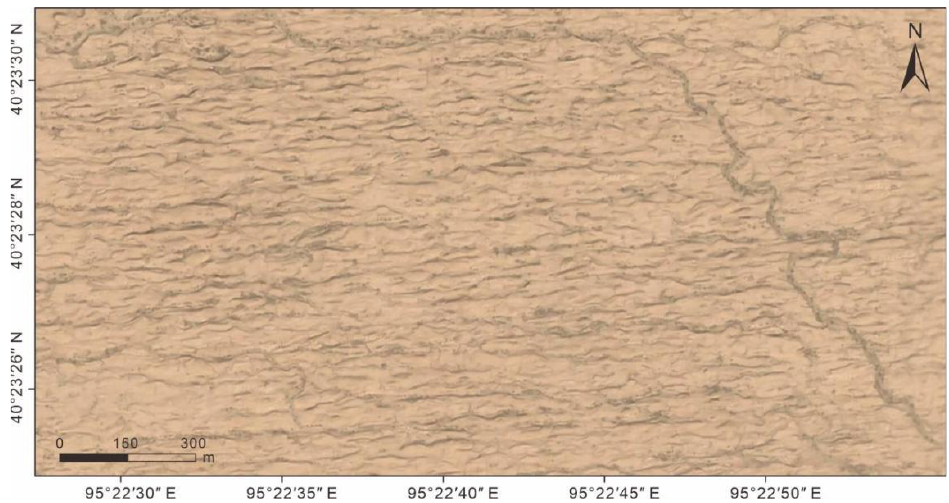
Figure 5. Remote sensing image of the yardangs surrounding the Suoyang City ruins.